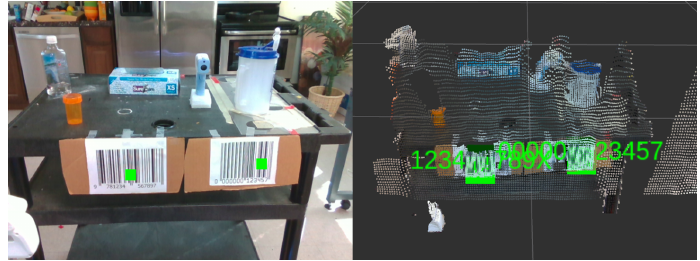
Figure 6. Two barcodes detected in the RGB image and indicated by green